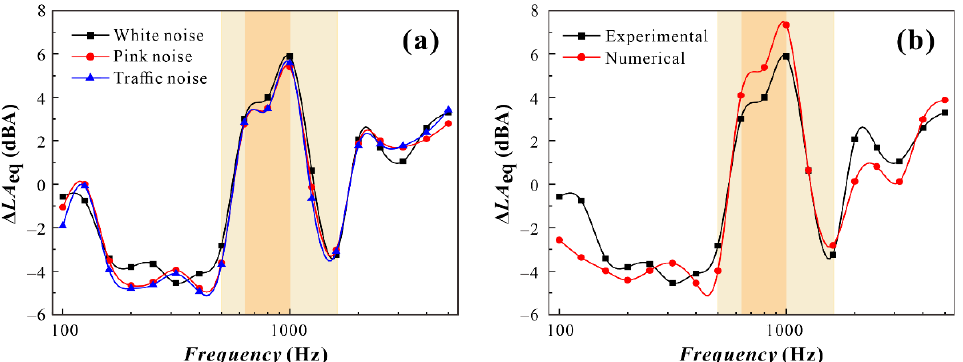
Figure 11. ( a ) The ∆ LA eq of three different noises; ( b ) Comparison of the ∆ LA eq for numerical and experimental results when noise was white noise.